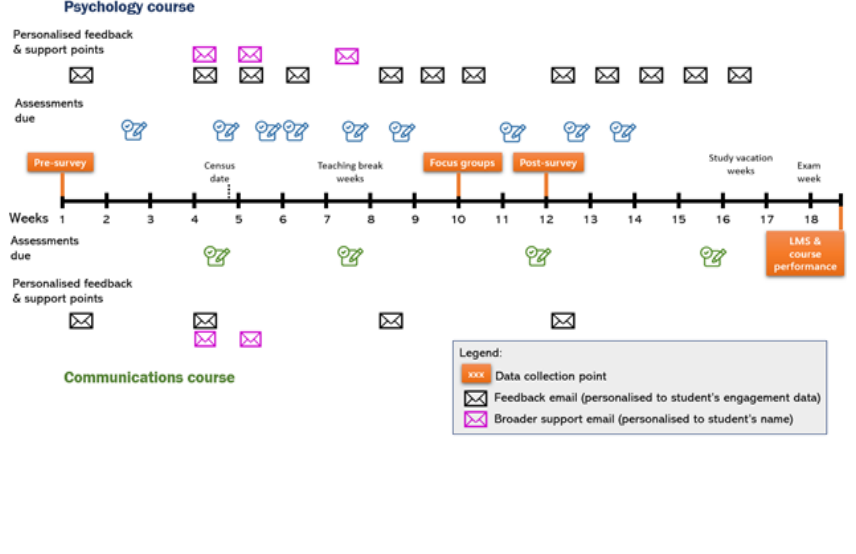
Personalised Feedback and Support Points It can be tough balancing your job with the demands of university study but you are not alone. Chances are the tutor you’re currently working on that assignment for right now also had a job while studying … and 3 in 5 of your class - mates are also working while at uni. So it’s good to know you’ve got options if the deadlines start piling up and you get that sinking feeling.